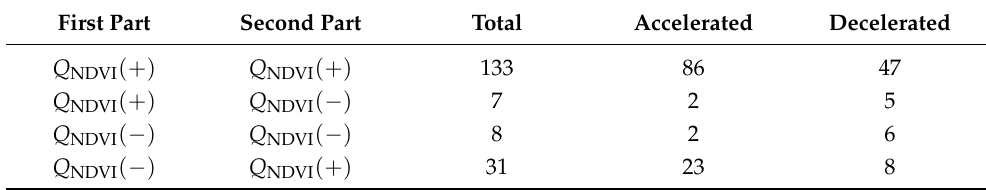
Figure 8. Strength of the seasonal component ∆ NDVI for the study period 1984–2021. Table 2. Dune cases for each combination of trend directions ( Q NDVI ) over the first and second part (typically 20 years each) of the study period. Q NDVI (+) and Q NDVI ( − ) represent greening and mobilizing dunes, respectively. Only sites with statistically significant Q NDVI during the entire study period were